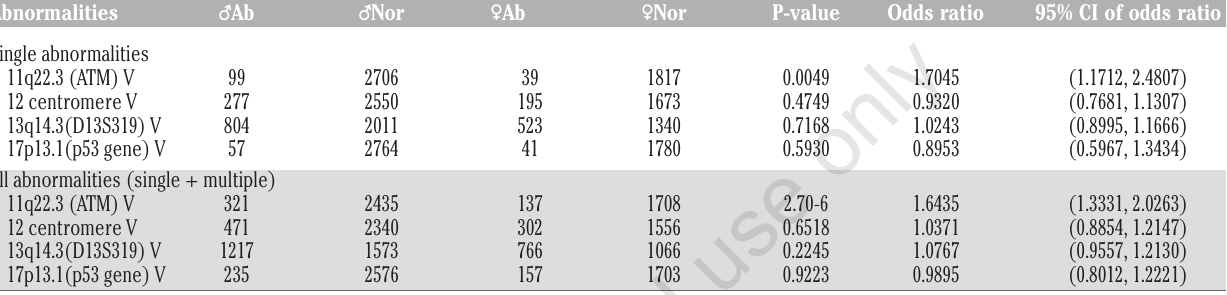
Table 4. Statistical analyses of abnormalities found in the chronic lymphocytic leukemia study population evaluated by the fluorescence in situ hybridization panel.